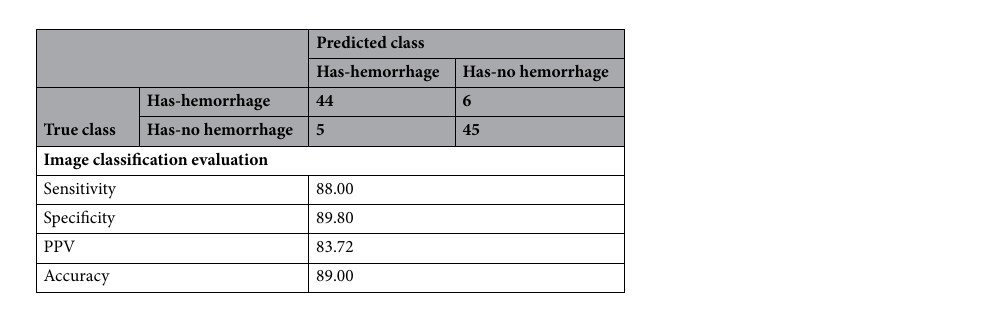
Table 4. Confusion matrix of image